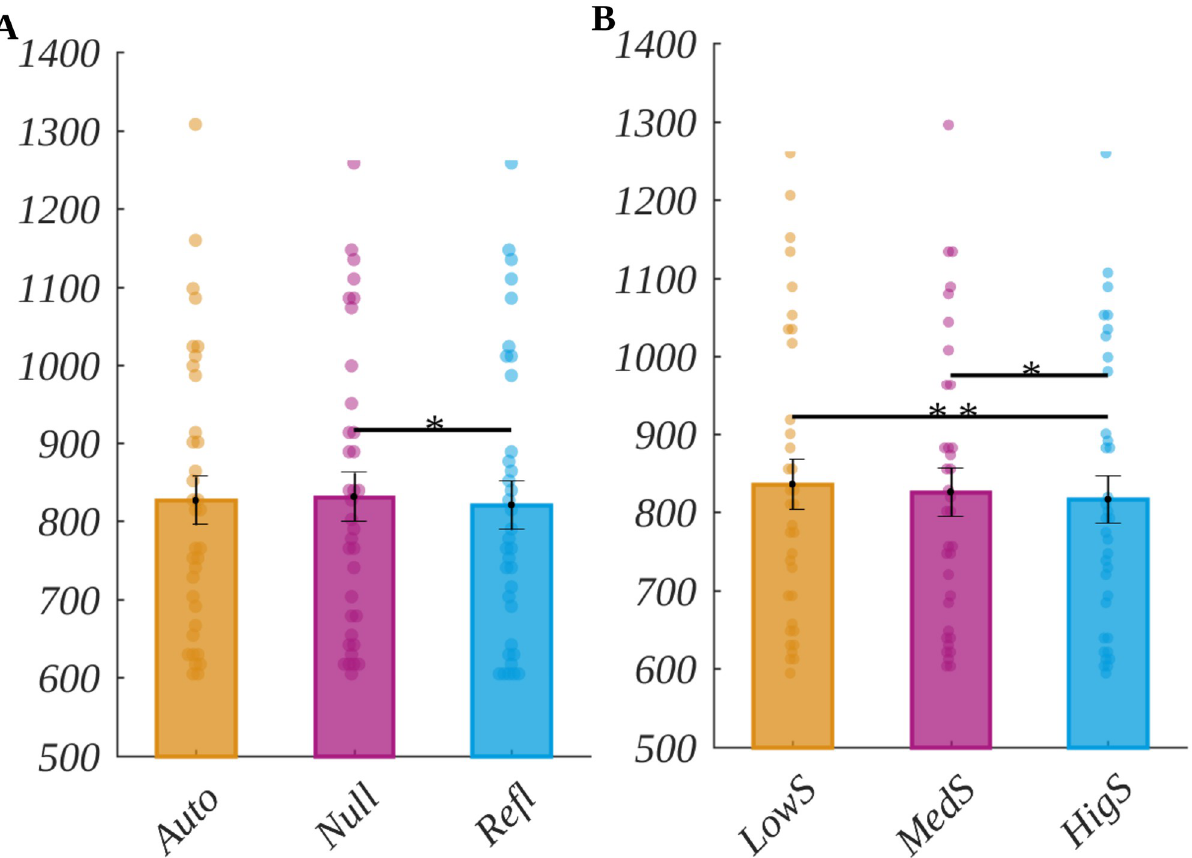
Fig 2. Main effects in reaction times for: A origin, B subjective significance. The bars represent the mean value, error bars SEM, individual dots mark the average response time of an individual subject in the given condition, the black horizontal lines indicate pairs of conditions with significantly different means ( �� p < .01, � p < .05). Response time is given in